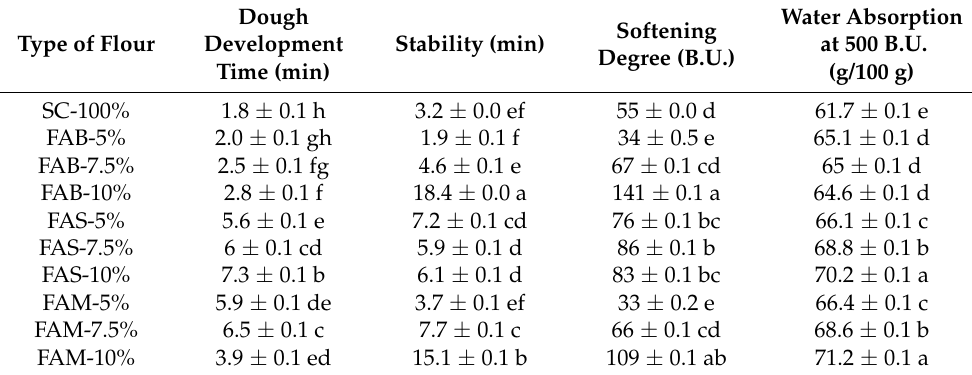
Table 3. Farinograph data of re-milled semolina (control) and of mixes prepared at increasing levels of replacement (5, 7.5, 10%) with flours from artichoke stems and bracts. Water Absorption Dough Softening at 500 B.U. Type of Flour Development Stability (min) Degree (B.U.) (g/100 g) Time (min) SC-100% 1.8 ± 0.1 h 3.2 ± 0.0 ef 55 ± 0.0 d